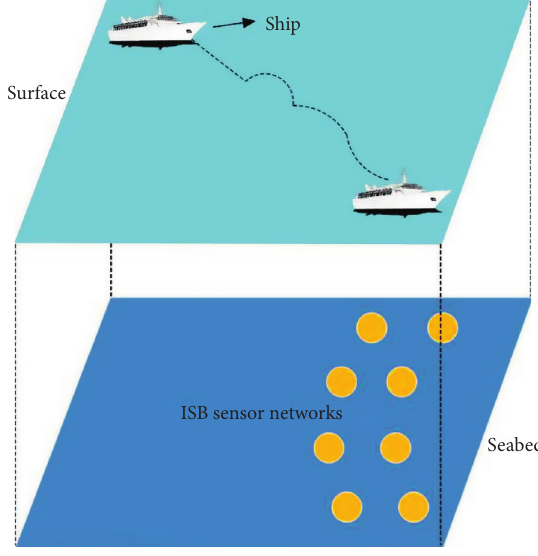
Figure 12: Simulation scenario: a ship is approaching to the ISB from a